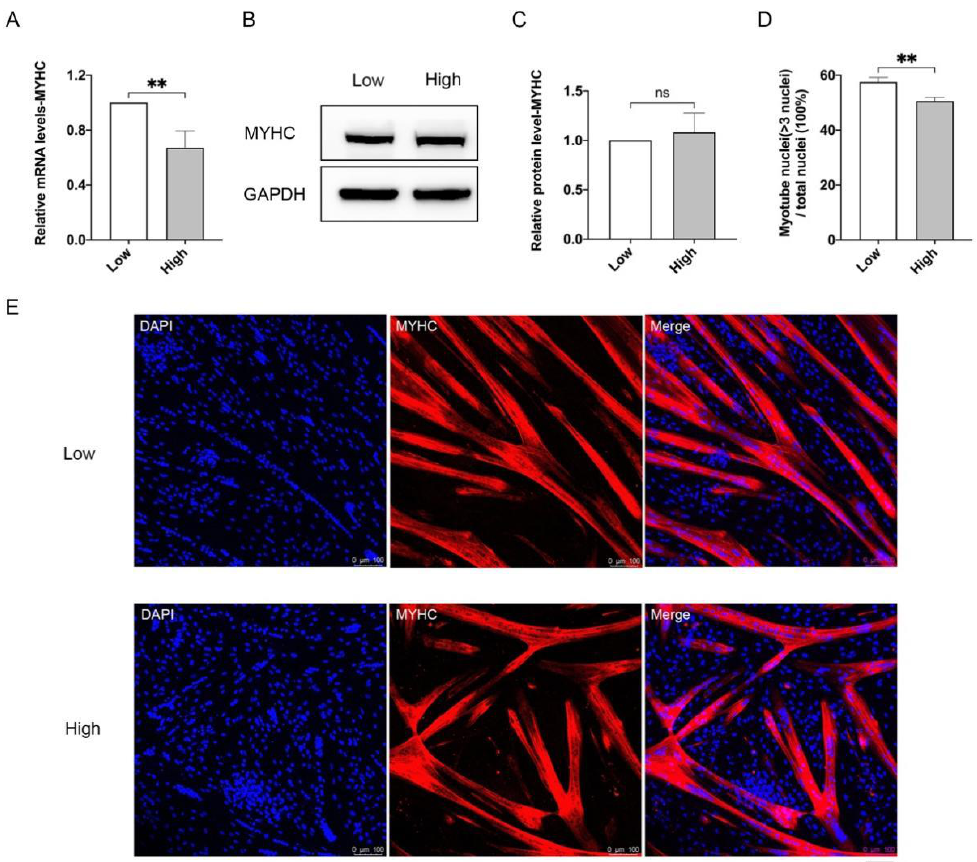
Figure 2. The differentiation capacity of MuSCs under low and high densities. MuSCs were seeded at 2.7 × 10 3 /cm 2 (low) and 2.2 × 10 4 /cm 2 (high), cells were harvested after three days culture and seeded onto Matrigel-coated dishes at equal densities to differentiate for 5 days. ( A ) qPCR analysis of MYHC mRNA levels. ( B ) MYHC protein levels by Western blot. ( C ) Relative protein levels of MYHC normalized to GAPDH indicated in ( B ) by Quantity One software. ( D ) Quantification of the percentage of myotubes with more than three nuclei. ( E ) Immunofluorescence staining of MYHC (red) and nucleus (blue). Mean ± SD from three independent experiments. Significance was analyzed by Students’ t -test. ** p < 0.01, ns, not significant ( p > 0.05).